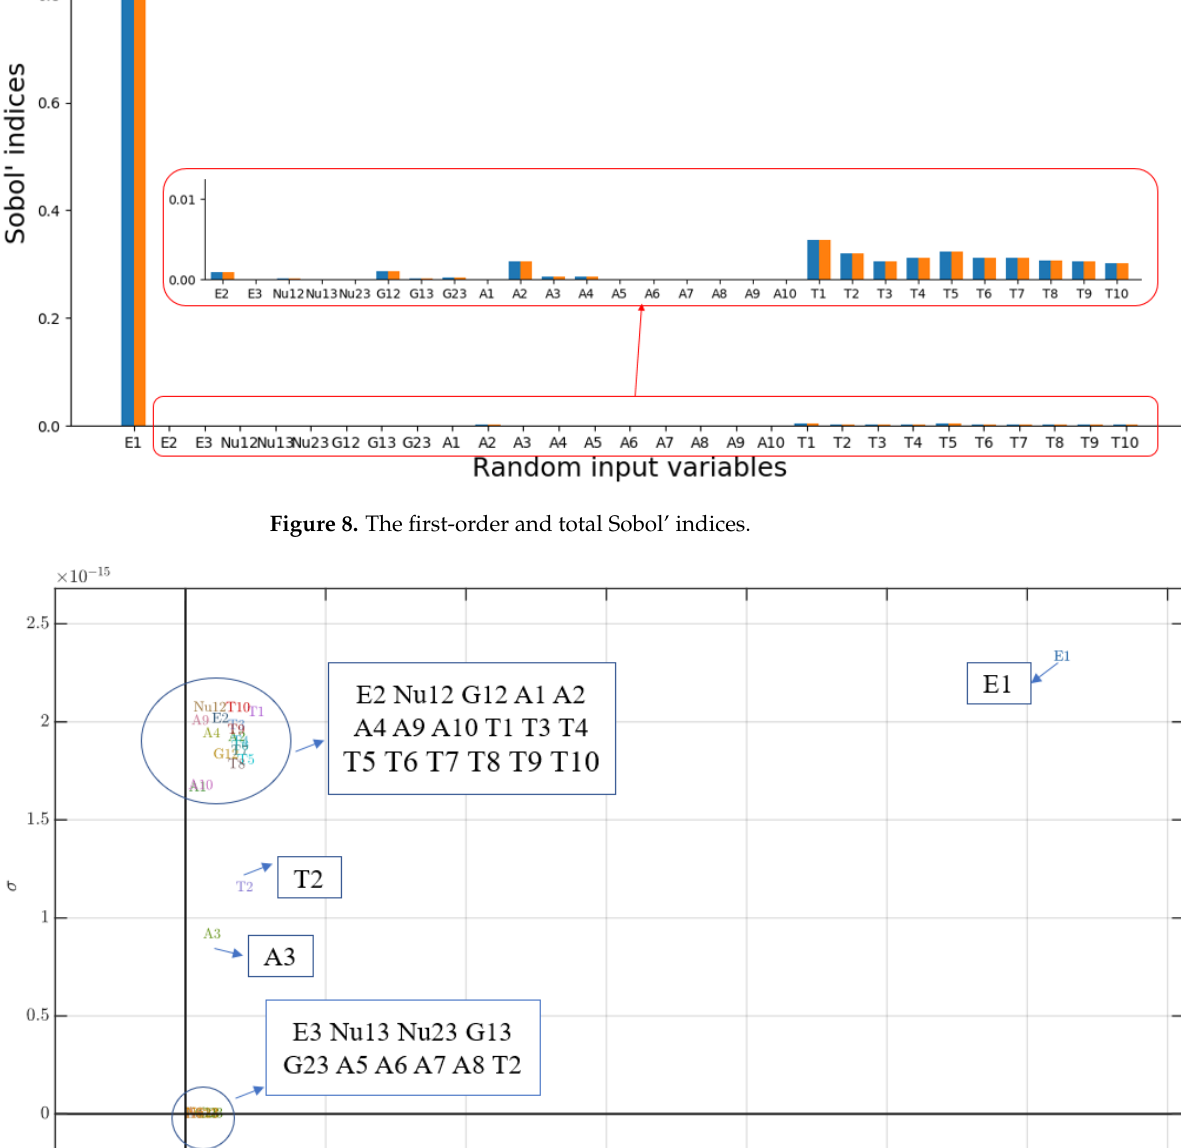
Figure 8. The first-order and total Sobol ’ indices.